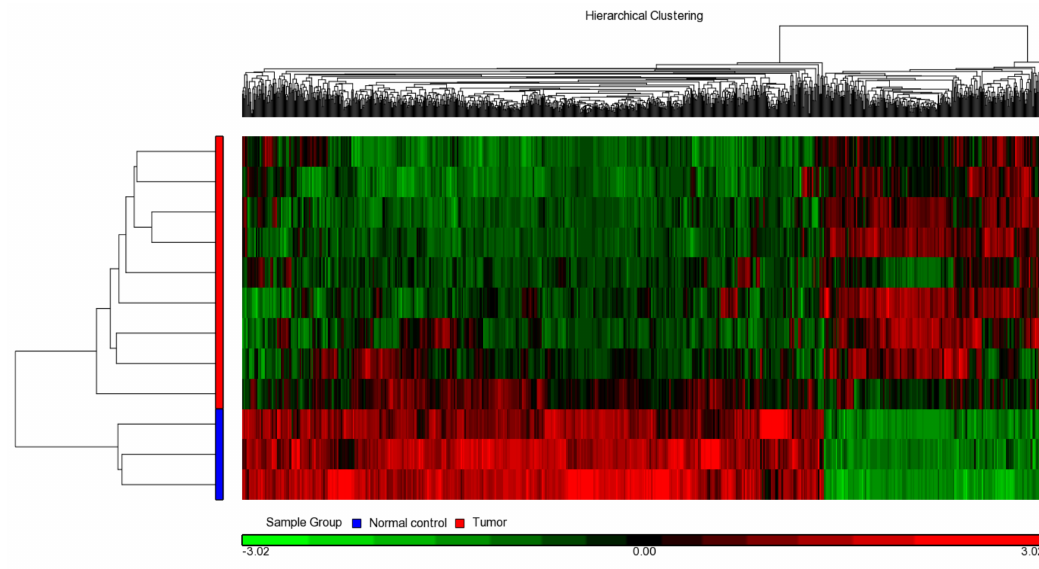
Figure 2. Comparative transcriptome analysis in human UTUC tumor and non-tumor samples. The total RNA isolated from human UTUC tumors ( n = 9) and adjacent normal tissues ( n = 3) was subjected to transcriptome analysis on Illumina HT12 microarray chips. The expression data was used for heat-map clustering